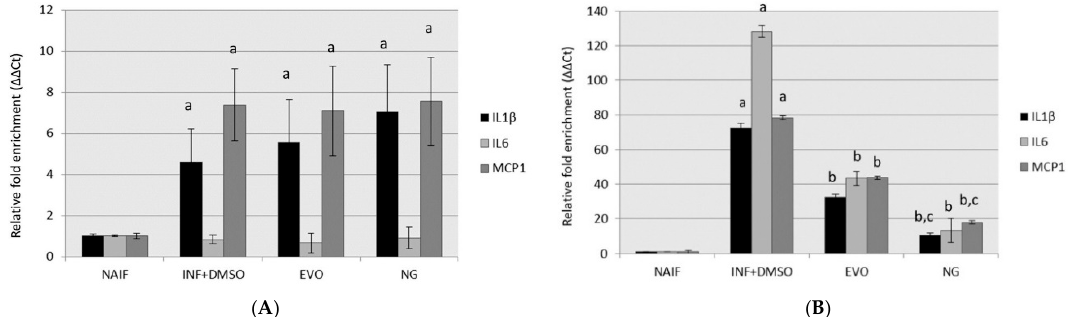
Figure 3. Gene expression of inflammatory genes after the treatment for the two experimental conditions: ( A ) SET1; ( B ) SET2. Statistically significant differences are indexed as follows: a = vs. NAIF; b = vs. INF + DMSO; c = vs. EVO.